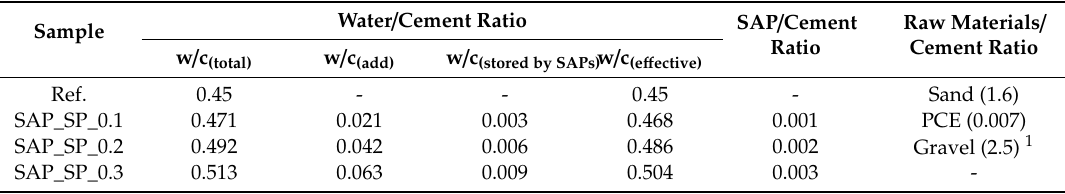
Table 1. Mix proportions of the samples (mass % of cement).